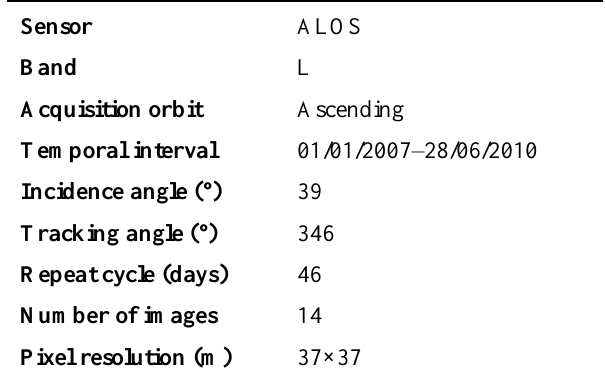
Table 1. Main acquisition parameters of the Synthetic Aperture Radar (SAR) satellite ALOS dataset in the Tramuntana